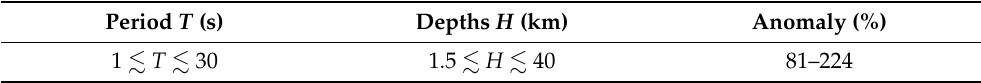
Table 3. ρ a anomaly depending on the depth H .